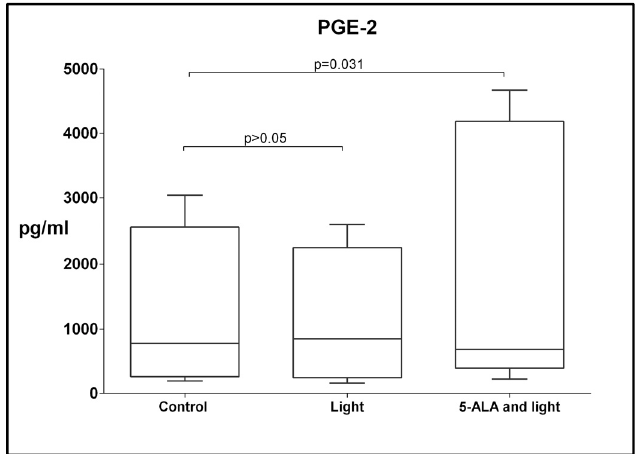
Figure 7. Boxplot showing the change in the levels of PGE2 across paired samples of control cell cultures, cell cultures treated with light only, and cell cultures exposed to 5-ALA and light. The effect of the PGE2 secretion on the protein levels was evaluated using ELISA Kit for human PGE2. Every dot on the box plot represents the levels of PGE2 in pg/mL produced by GBM-MSCs in that particular cell culture.